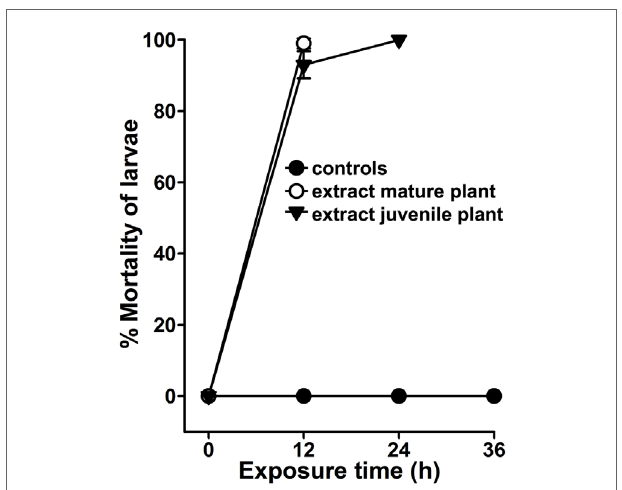
FigUre 6 | Agave larvicidal activity is independent of the plants vegetative growth. A. aegypti larvae were exposed to 100 μ g/ml aqueous extract prepared from the leaves of a mature (~44 ″ in height) or juvenile (~12 ″ in height) Agave angustifolia plants. Percentage larval mortality at each time point was calculated against the sham-treated controls and represented as the mean ± SD of